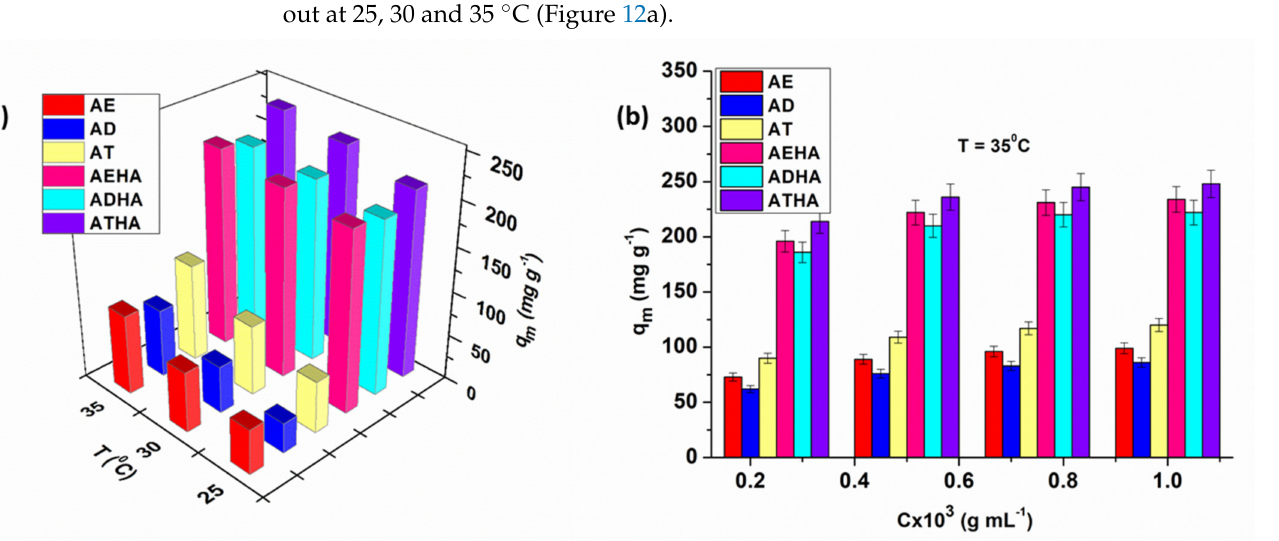
Figure 12. Influence of temperature ( a ) and the initial concentration of metronidazole ( b ) on the adsorption capacity of the drug onto precursor/hybrid